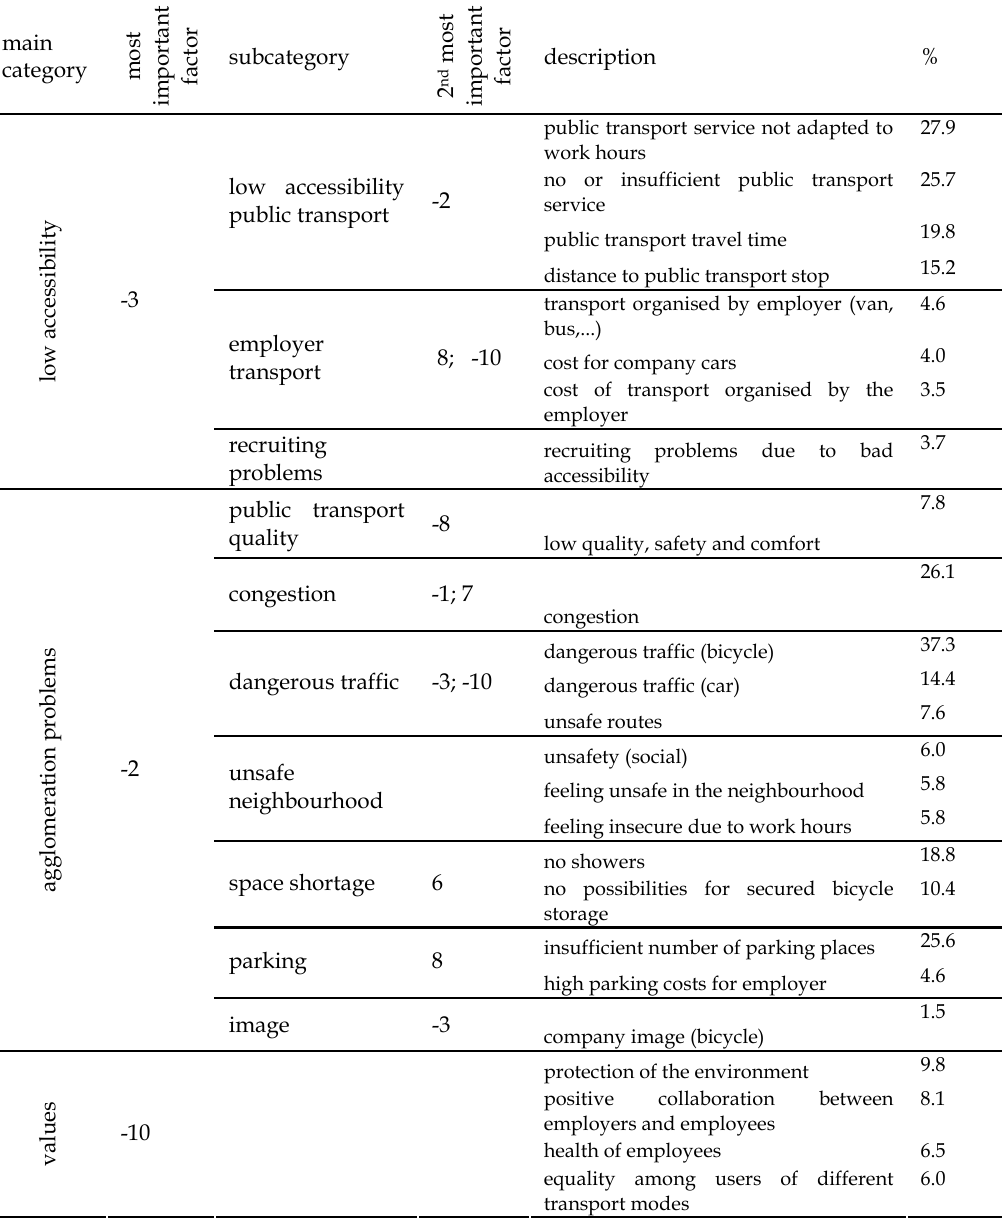
Table 4. Classification of problems with and remarks on